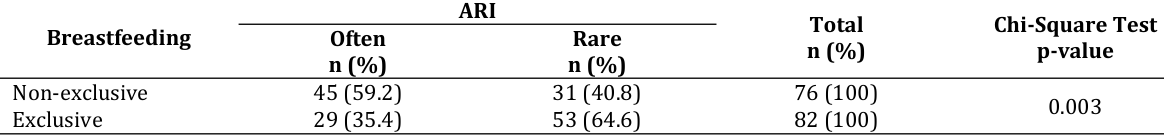
Table 1. The comparison of ARI occurrence in toddlers who were given exclusive and non-exclusive breastfeeding (N=158) Breastfeeding